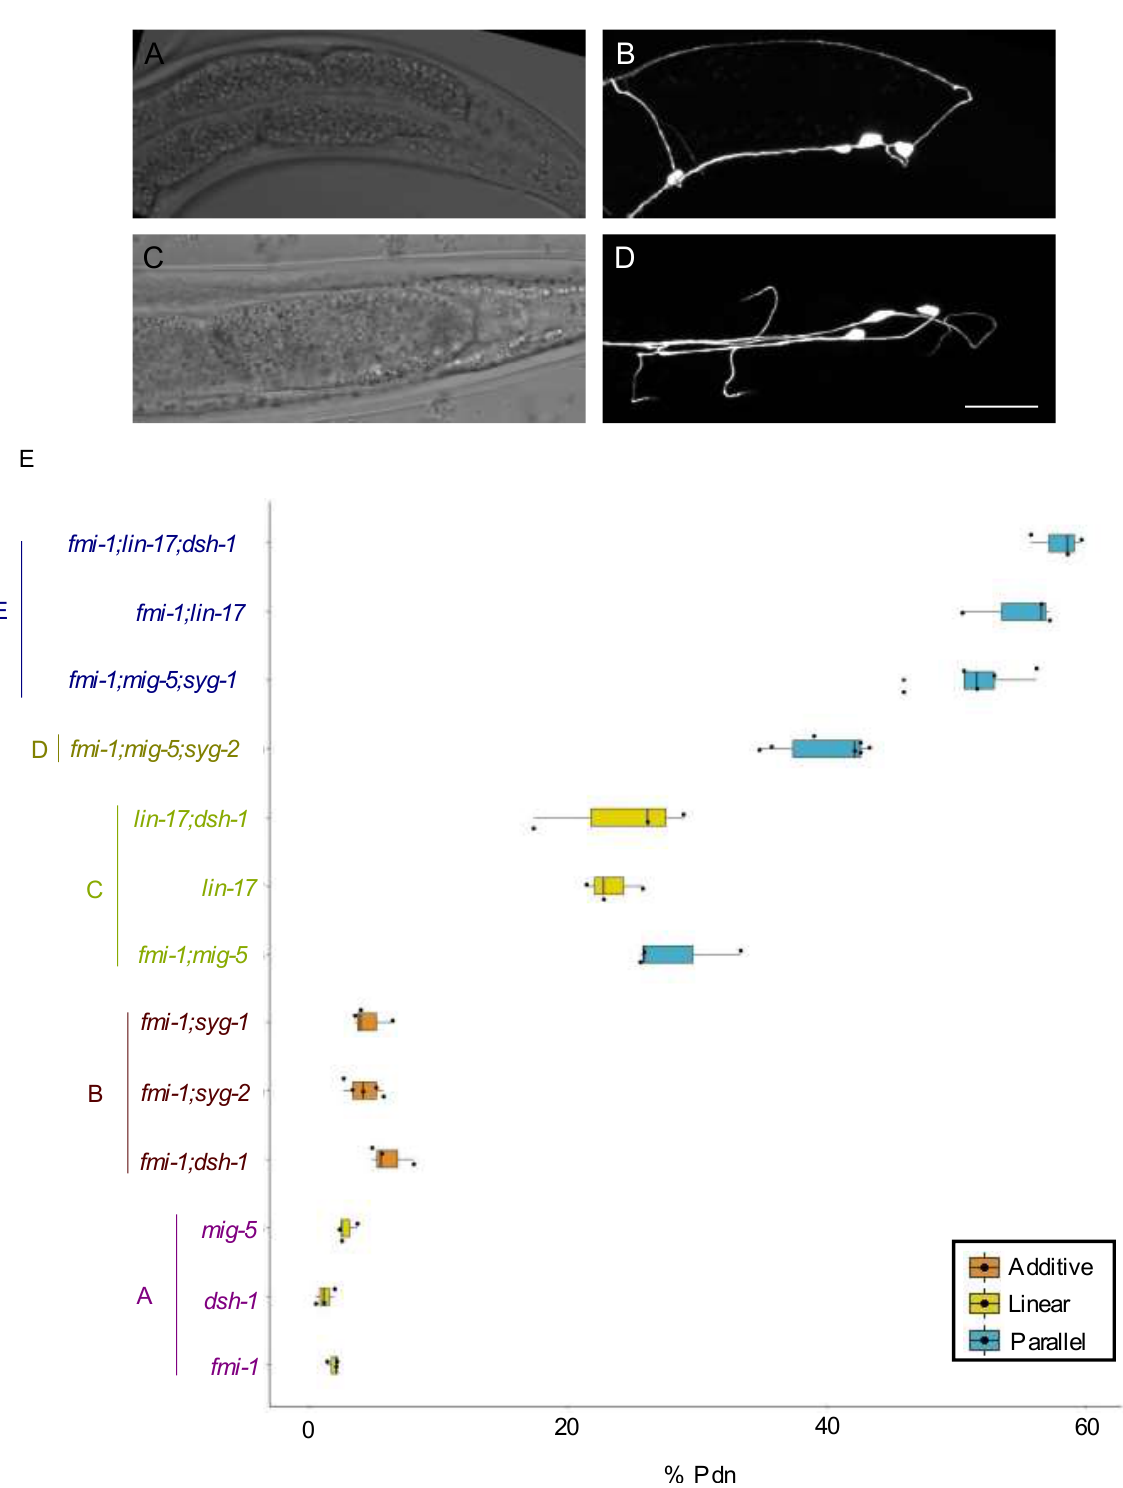
Figure 3. Genetic interactions between the Syg, Fmi and Wnt pathways in Pdn development. ( A – D ) Representative images of the percentage of fmi-1;mig-5;syg-2 animals displaying Pdns. ( A , B ) Lateral view. ( C , D ) Ventral view. ( E ) Boxplots of Pdns observed by genotype. Significance groups are color coded and indicated by letters. Each genotype within a group is not significantly different from the others in the same group but is significantly different from all genotypes in the other groups by pairwise comparisons. The color of the boxplot demonstrates the type of genetic interaction concluded by our